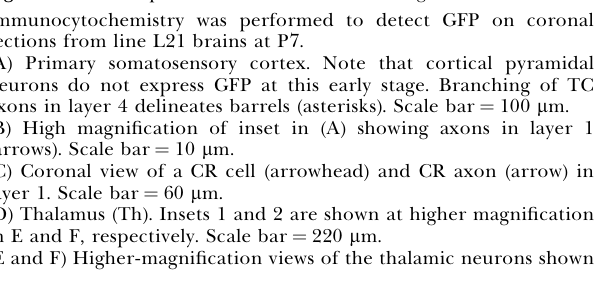
(B) Axons were imaged in superficial layers of cortex over several days and up to 2 wk. (C) The unique pattern of blood vessels in each mouse was used to find the regions of interest from one imaging session to the next. (D) Axons were then traced from overlapping stacks of images. (E) In order to confirm the identity of thalamocortical axons, some animals were fixed by perfusion and the previously imaged axons were reconstructed using BREBIS (see Figure 1; Materials and Methods) Found at DOI: 10.1371/journal.pbio.0030272.sg002 (3.3 MB PDF). Figure S3. Tortuous Path of CR Axon Growth Cone and Interstitial Branching in TC Axon (A) Time lapse sequence showing the tortuous path of a CR axon growth cone. Images are projections of 13–19 sections. (B) Time lapse sequence of the birth of a TC axon branch, starting with the de novo appearance of an interstitial growth cone within the shaft of the TC axon. Time stamps in hours. Found at DOI: 10.1371/journal.pbio.0030272.sg003 (3.1 MB PDF). Figure S4. Examples of Growth, Branch Retraction, and Axonal Degeneration (A and B) Additional examples of growth (green arrows) and retraction (red arrows) of TC axon tips (see also Figure 4). (A) Initial imaging session; (B) Same field of view imaged 10 h later. The fragmented axon shown here (red arrow heads) is at an earlier stage of degeneration than the one shown in Figures 3 and 4. (C) Average length gained (growth) or lost (retraction only) for TC (black) and CR (gray) axon tips at various ages throughout postnatal development. The differences in growth between TC and CR axons were statistically significant at P4–P7 ( p , 0.0001), P9–P11 ( p , 0.05), and P11–P13 ( p , 0.05). The differences in retraction between TC and CR axons were statistically significant at P4–P7 ( p , 0.0001), P7– P9 ( p , 0.001), and P9–P11 ( p , 0.01). (D) Time lapse images obtained at 1-h intervals of a cortical axon from a P4 mouse. Red arrows indicate branches that are retracted. Note that branch tip retraction is distinct from axosomal shedding in that it does not involve retraction bulbs and does not leave a trail of debris. Scale bar ¼ 5 l m. Error bars represent the SEM. Found at DOI: 10.1371/journal.pbio.0030272.sg004 (2.0 MB PDF). Figure S5. Summary Cartoon of the Different Modes of Axon Elaboration Used by Local Intracortical Axons (CR) and Long-Range Extracortical Axons